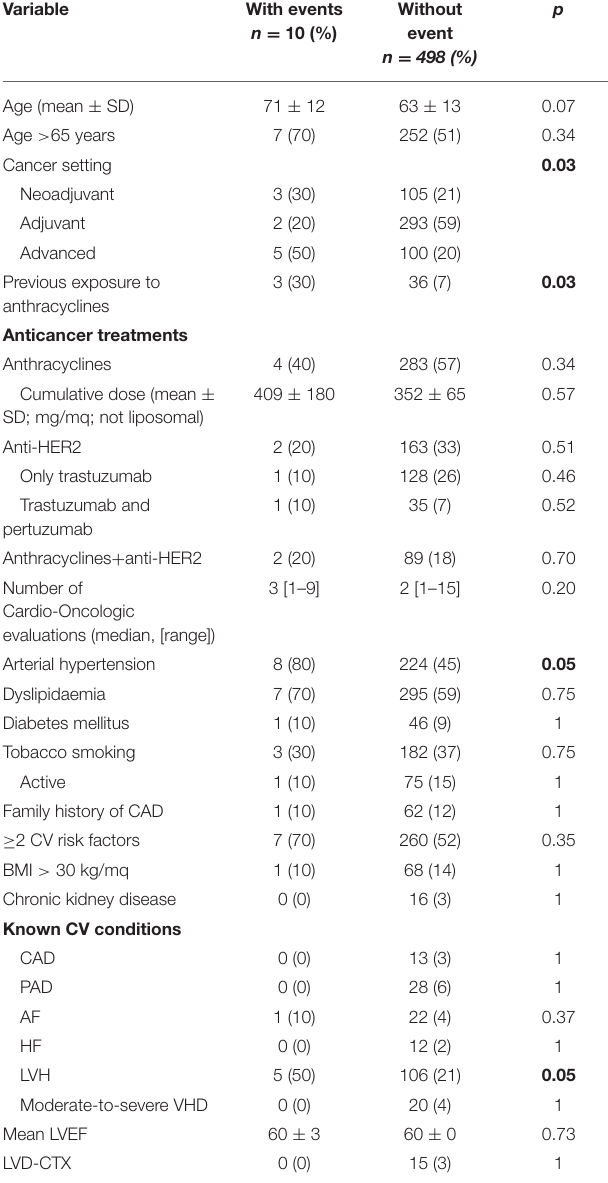
TABLE 3 | Characteristic of BC patients with and without CV events other than